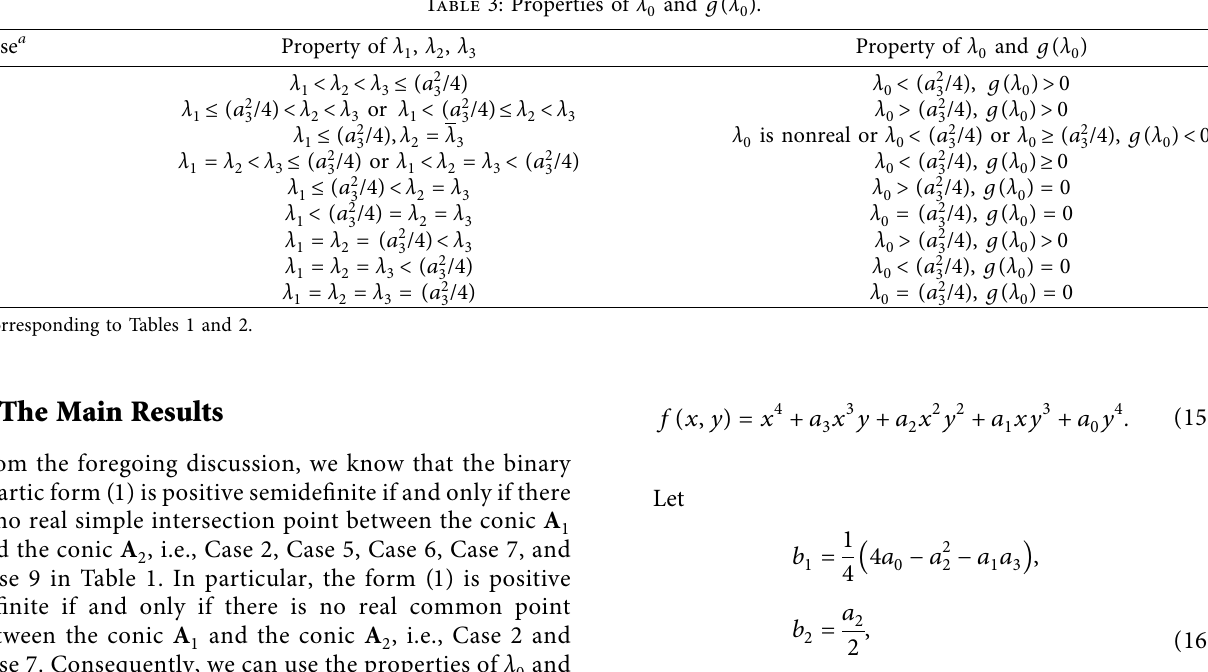
Table 2: Degenerate conics in the pencil M